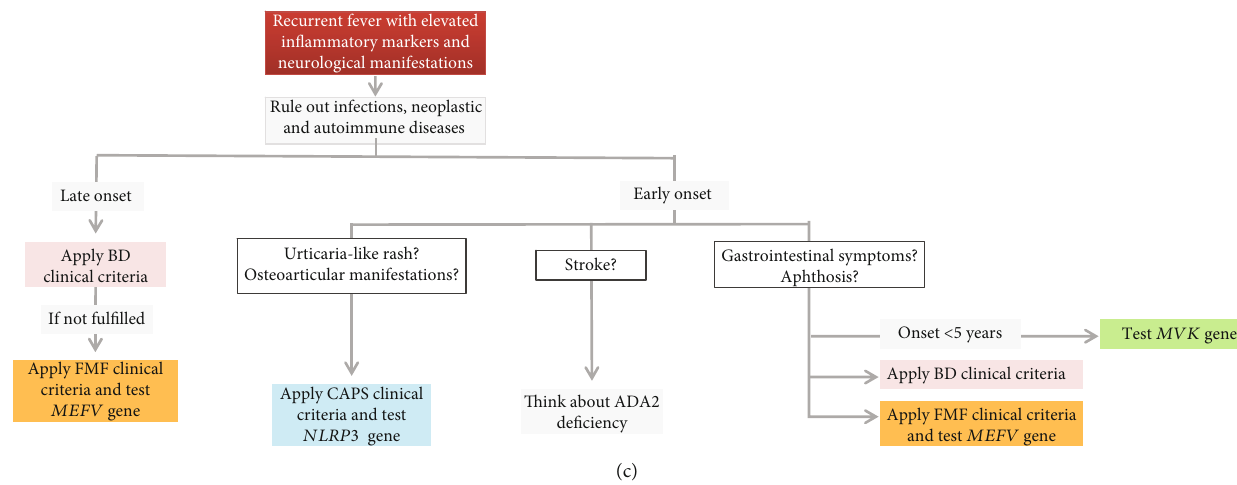
Figure 5: Diagnostic fl ow chart for main autoin fl ammatory diseases displaying recurrent fevers and gastrointestinal (a), serosal (b), and neurological (c) manifestations. List of abbreviations: FMF — familial Mediterranean fever; PFAPA — periodic fever, aphthous stomatitis, pharyngitis, and cervical adenitis; BD — Behçet ’ s disease; CAPS — cryopyrin-associated periodic syndrome; AOSD — adult-onset Still ’ s disease; NLRC4 — nucleotide-binding domain, leucine-rich repeat, and caspase recruitment domain-containing 4; ADA2 — adenosine deaminase